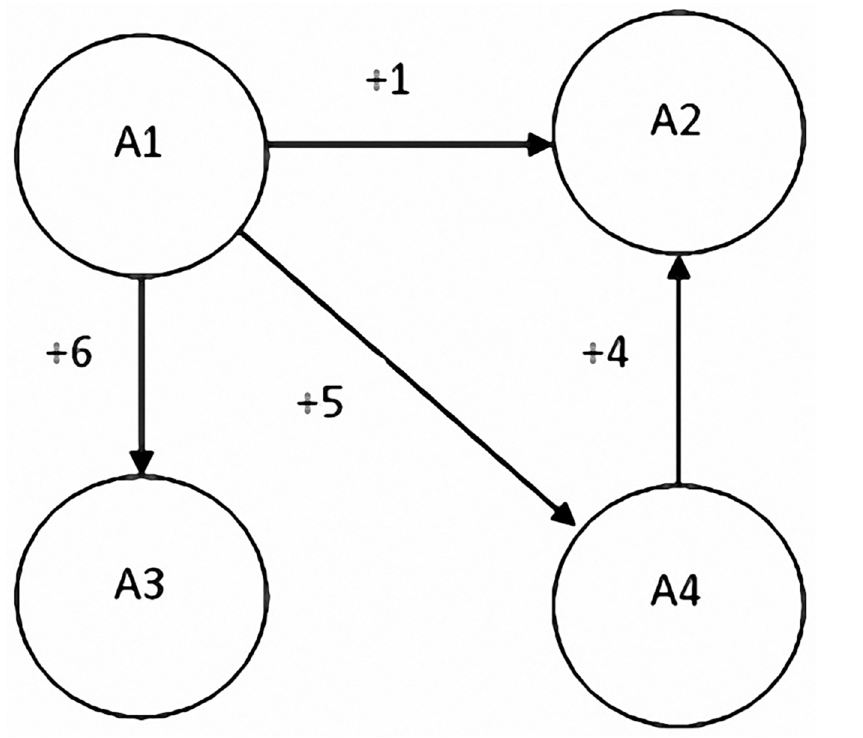
Fig 1. The Affect relationship diagram.